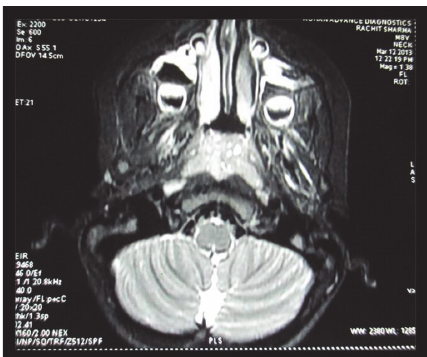
Figure 4: MRI showing aplasia of lacrimal and salivary